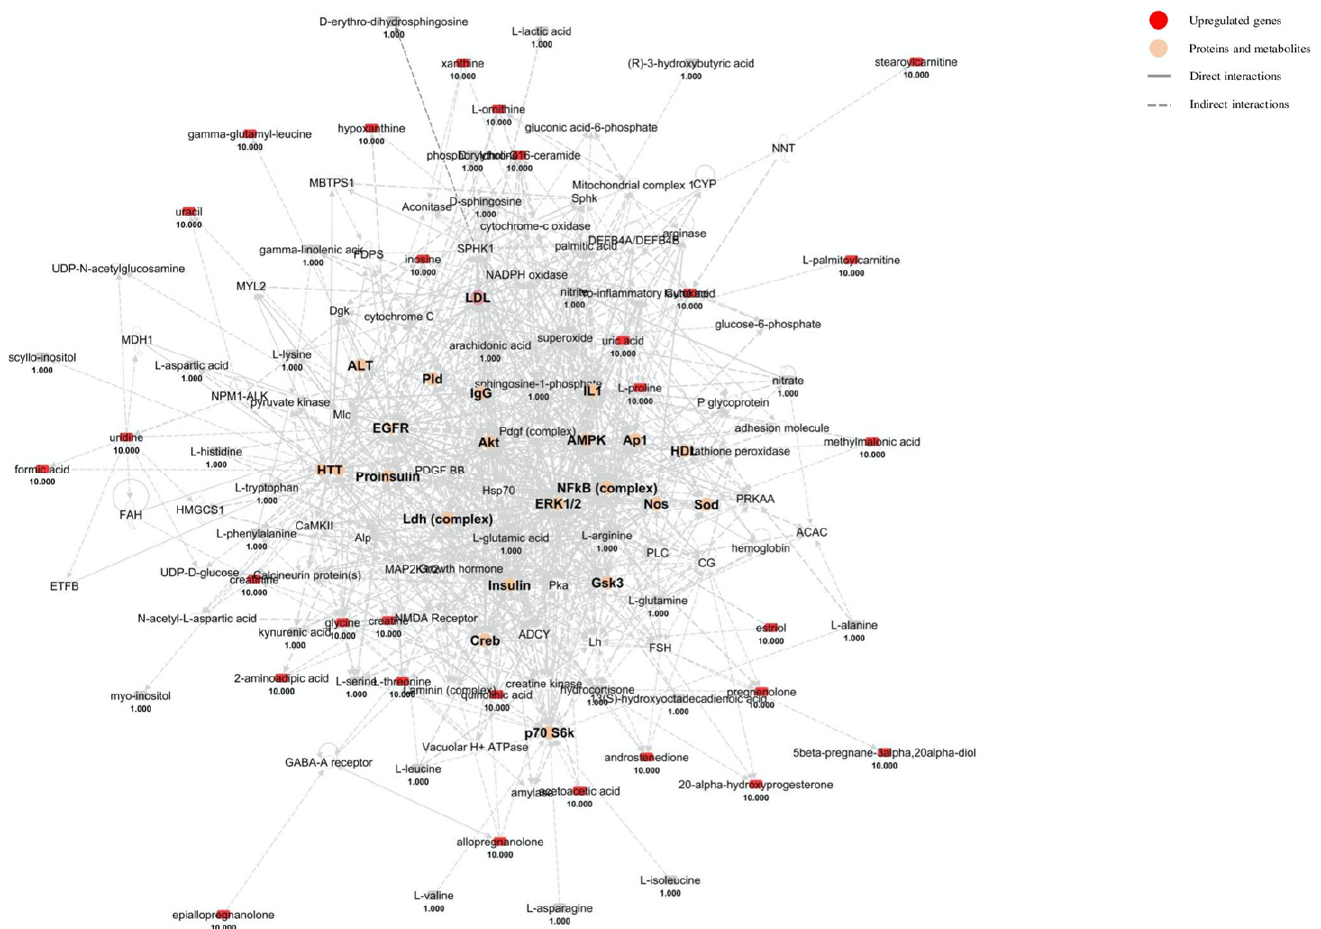
Figure 4. Merged networks based on inter-metabolite connections from the blood matrix. Red shapes indicate genes significantly decreased in expression in MS, whereas the number below represents the fold change log. The relationship between genes may lead to direct (solid lines) or indirect interaction (dashed lines). Light orange shapes indicate proteins and metabolites from the blood matrix.